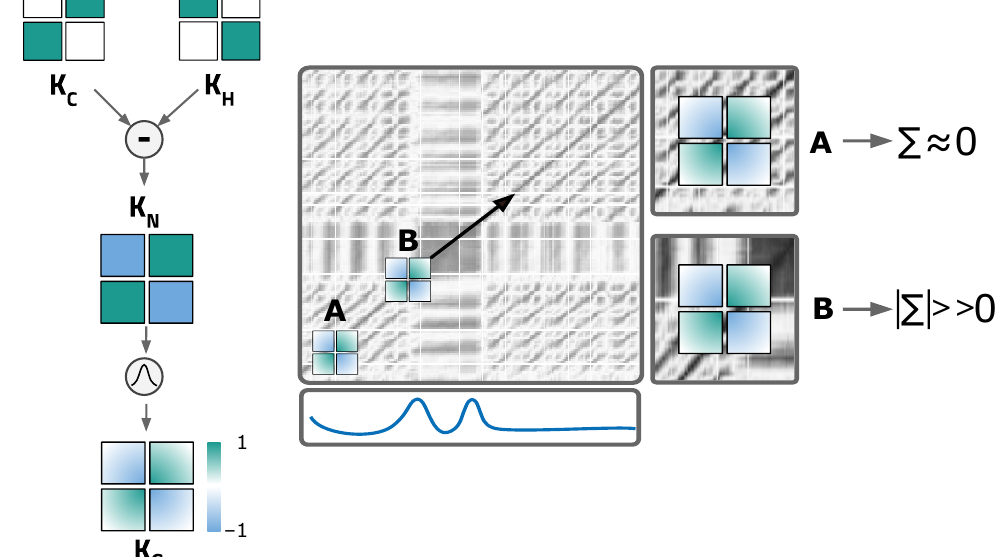
Figure 5. ( Left ): description of the matrix (kernel) used to compute the novelty function , based on the works of Mueller et al. [2,73]. The chequerboard pattern of the kernel K N is achieved by combining the kernel K H (homogeneity measure) and K C (cross-similarity measure). Combined with a Gaussian function, the K G is obtained; ( right ): the process to compute the novelty function based on the works of [2,73,94]. Kernel K G slides along the diagonal of the SSM to compute the novelty function presented as the bottom sub-plot. Positions A and B point to the effect of block transitions on the novelty function